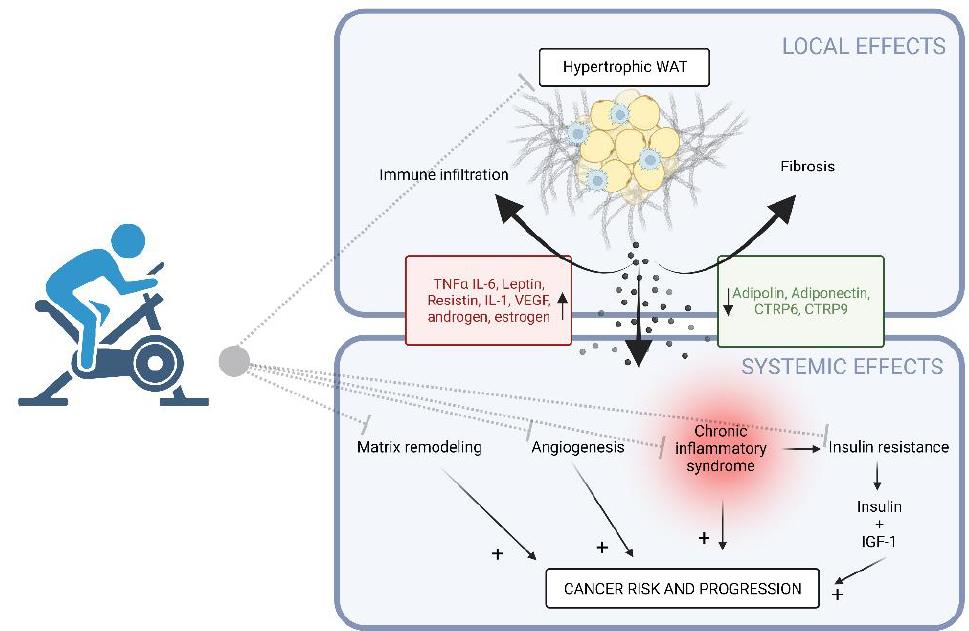
Figure 1. Local (immune infiltration, fibrosis) and systemic (matrix remodeling, angiogenesis, chronic inflammatory syndrome and insulin resistance) effects of hypertrophic white adipose tissue in obesity, on the cancer risk and progression and the potential inhibitory effects of exercise on these different changes. Black dots illustrate the gradient of adipokines and plus signs represent the different mechanisms contributing to cancer risk and progression. Created with BioRender.com.